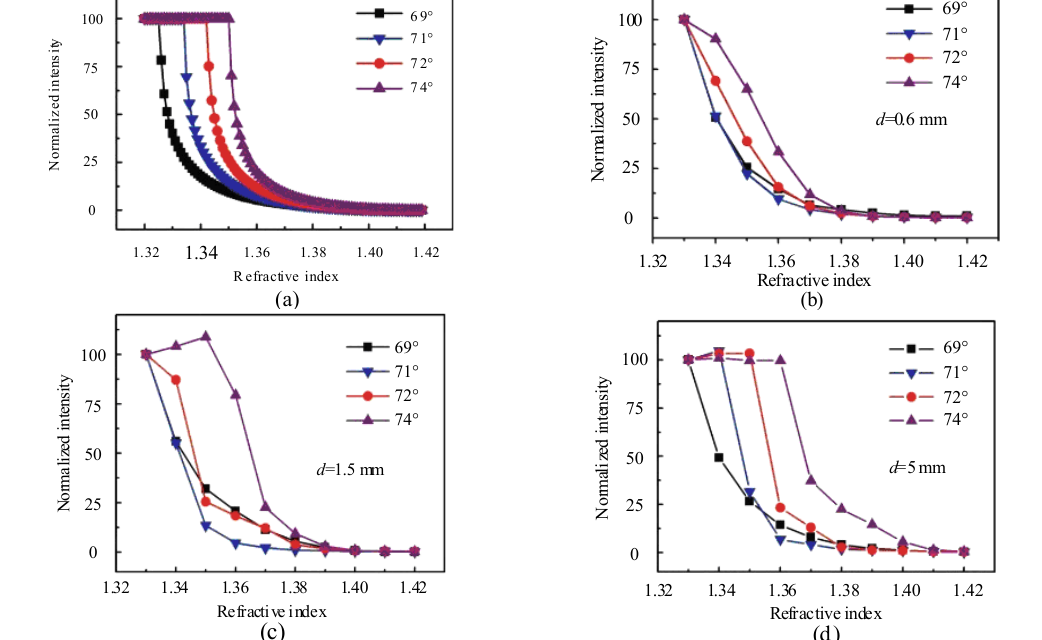
Fig. 4 Reflection response of the RI sensor for different  : (a) theoretical analysis of the reflection response of the RI sensor for different  and (b)–(d) normalized intensity of the reflected light collected by four output fibers with reflected angles of 69°, 71°, 72°, and 74°, respectively, except for the variations to the distance between the endface of an output fiber and the reflection zone as indicated in the